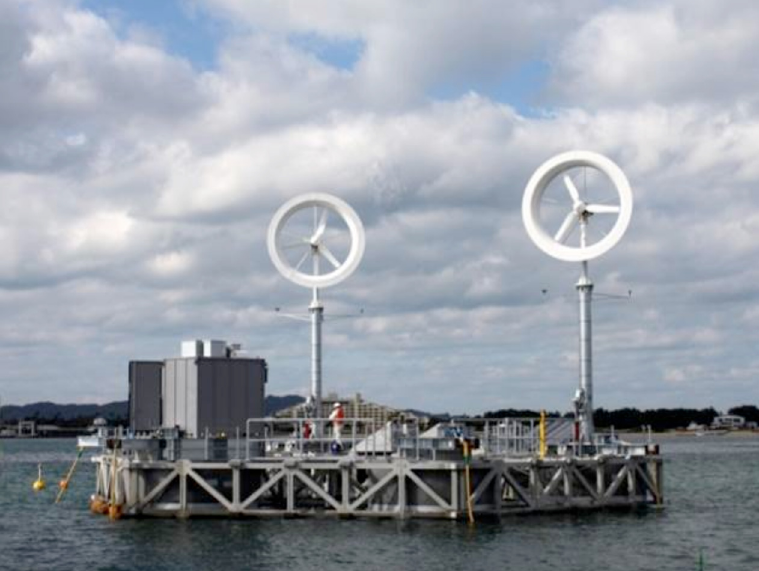
Fig. 5. Eighteen meter wide concrete platform of offshore hybrid farm experiment by Kyushu University at Hakata Bay, Japan.